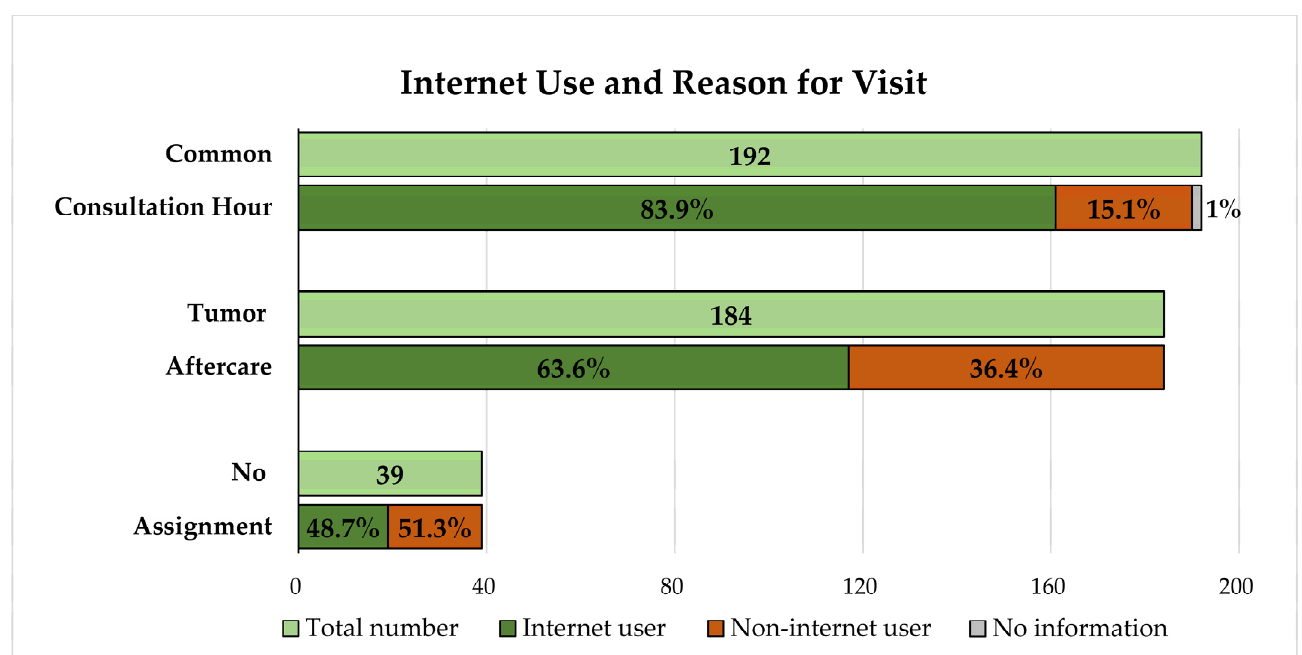
Figure 1. Visualization of the distribution of study participants regarding reason for visit and internet use. Internet users are colored in dark green, non-internet users in orange. Missing information regarding internet use is colored in grey. The bar in light green visualizes the number of patients in each patient group and equals 100% of the group. Thirty-nine patients did not provide their reason for visiting.